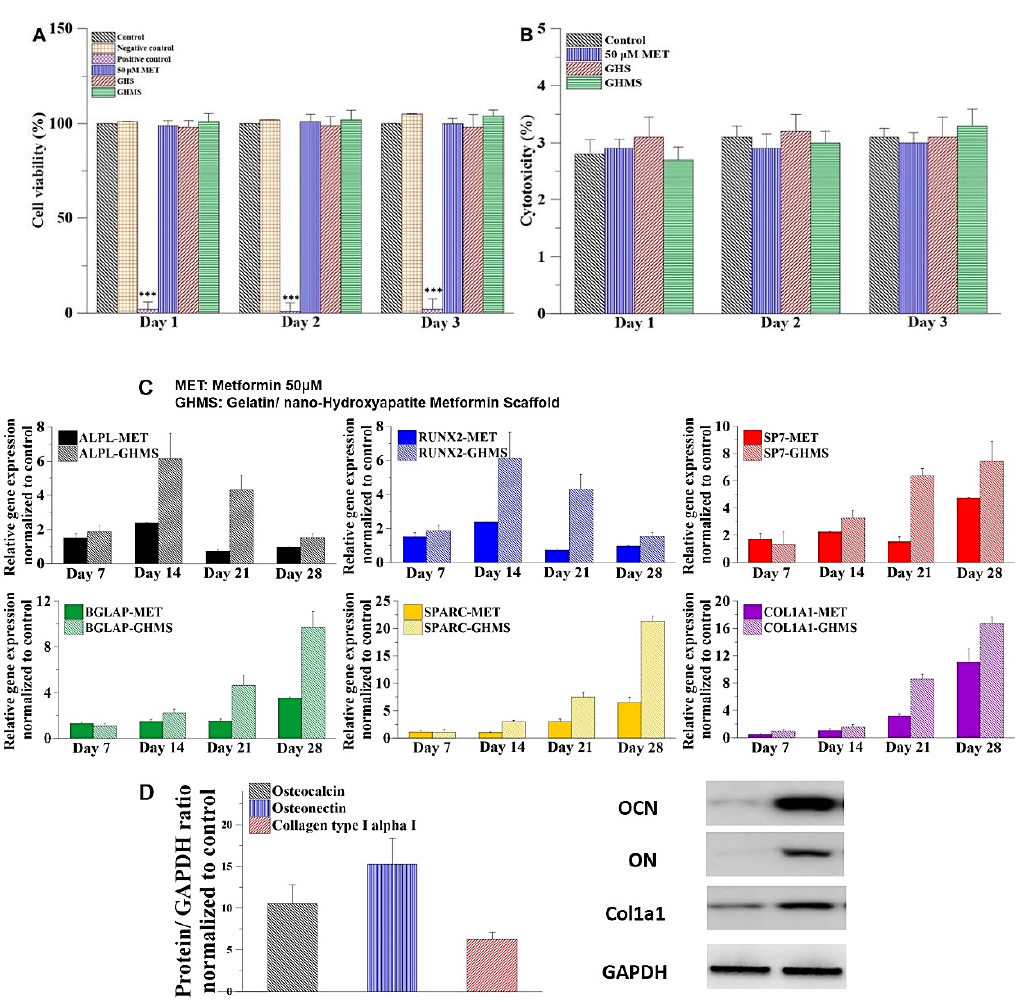
Figure 2. In vitro studies to evaluate the biocompatibility and osteogenic potentials of gelatin/nano- hydroxyapatite/metformin scaffold (GHMS). ( A ) Water-soluble tetrazolium (WST-1) assay. ( n = 12; *** p < 0.001) ( B ) Extracellular lactate dehydrogenase (LDH) Assay. ( C ) Osteogenetic gene expression and protein synthesis after coculturing human mesenchymal stem cells (hMSCs) with GHMS or 50 µ M metformin (normalized to the control group). The osteoblast-specific genes of the hMSCs, including alkaline phosphatase (ALPL), runt-related transcription factor-2 (RUNX2), osterix (SP7), osteocalcin (BGLAP), osteonectin (SPARC), and type I collagen (COL1A1) were upregulated compared to the control group. ( D ) Osteogenetic protein synthesis after co-culturing hMSCs with GHMS. The hMSCs co-cultured with the GHMS for four weeks showed osteogenic protein overexpression of osteocalcin (OCN), osteonectin (ON), and collagen type I (Col1a1) compared to the control